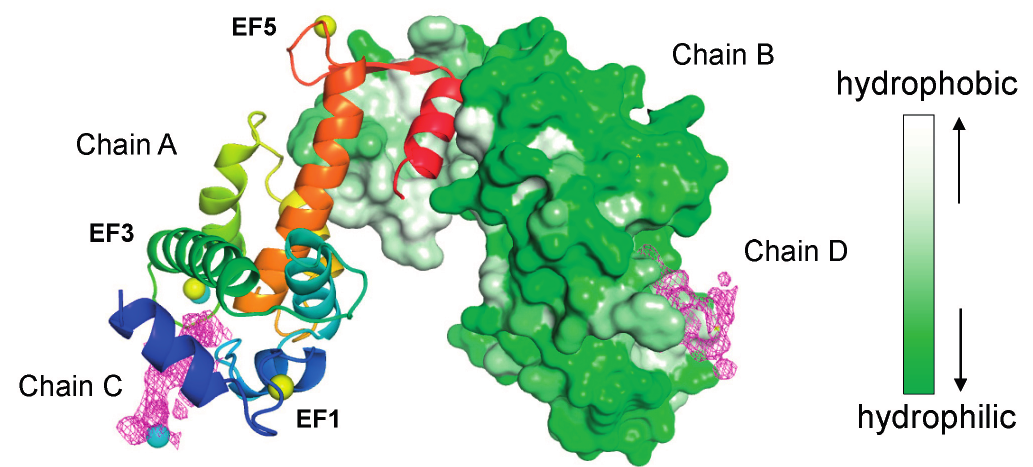
Figure 2. X-ray crystal structure of the complex between ALG-2 and the Sec31A